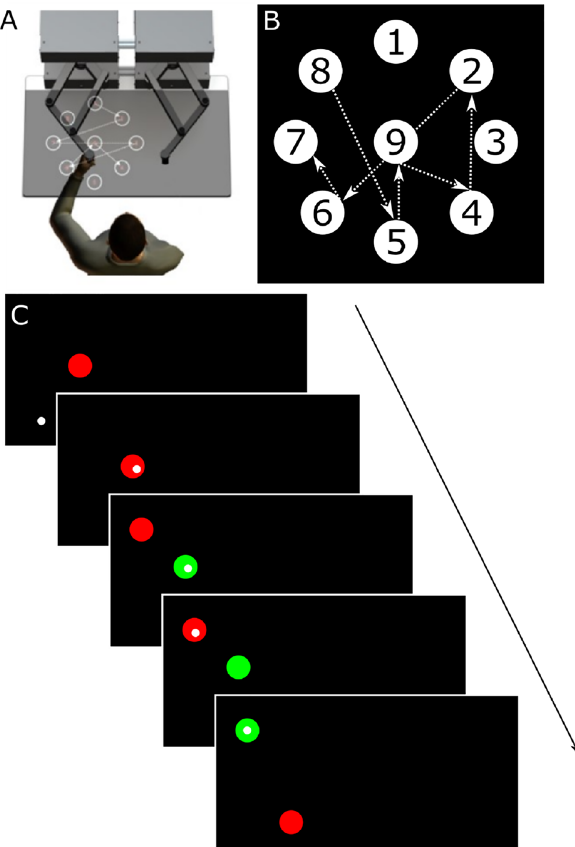
Participants used their non-dominant arm to control a frictionless lever to move to illuminated targets as quickly and accurately as possible. ( B ) Numbered targets displayed represent all targets in the workspace. The order of the embeded repeated target sequence is represented by the dotted arrows. Note, participants only saw 2 targets at any given time (when not next in the sequence the targets were not displayed) and targets were not numbered during the task. ( C ) The task began with the appearance of a red center target with a small white circle representing the participant’s non-dominant hand position in real time (top). A red targets stayed on the screen until the participant moved and held the white dot (i.e., their hand) in the red target for 500 ms, after which a new red target appeared and the current red target turned green simultaneously. This process repeated until participants completed one block (a total of 111 movements, 48 of which belong to a 6-element repeated target sequence). A total of 4 blocks were completed during each practice session. All targets are presented on the non-dominant side of the participant’s